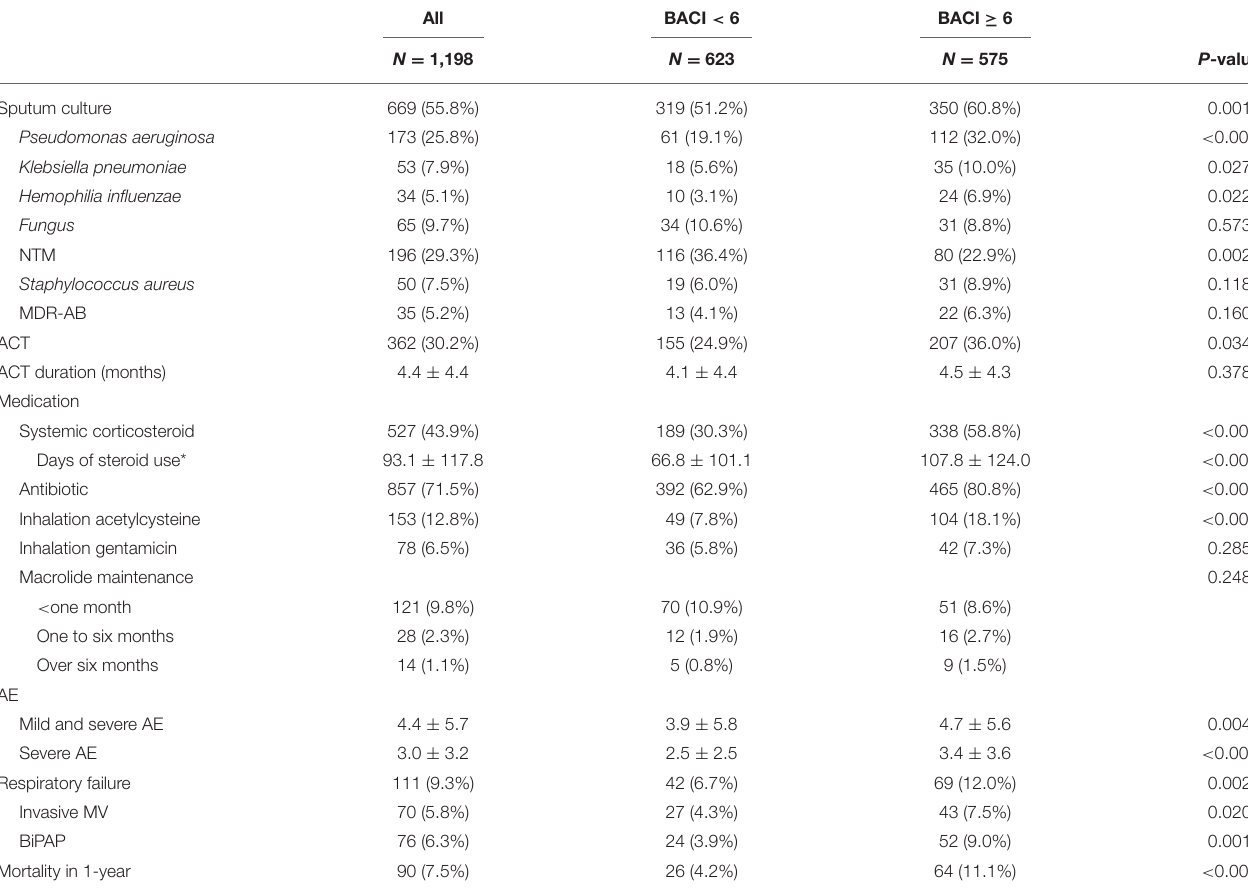
TABLE 3 | Main clinical outcomes during a 1-year follow-up.